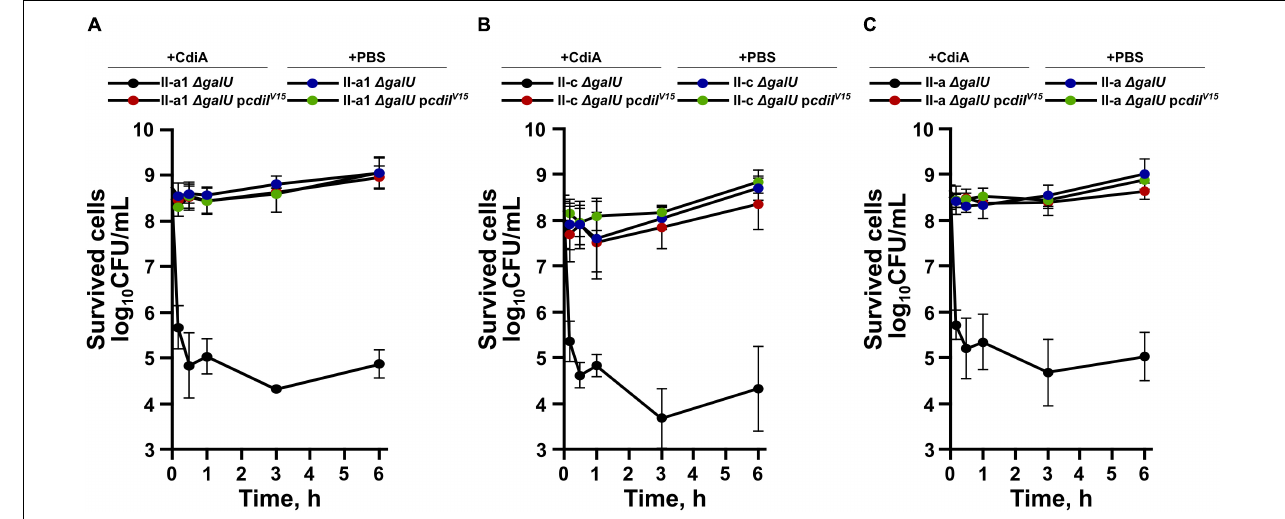
FIGURE 5 | Time-dependent bacterial viability assays of A. baumannii clinical strains II-a1 (A) , II-c (B) , and II-a (C) , their galU mutants, and galU mutants complemented with immunity gene cdiI V15 from the A. baumannii V15. The viabilities after the addition of either PBS or the purified CdiA were assessed by measuring the remaining bacterial CFUs at the following time points: 0 h, 10 min, 30 min, 1 h, 3 h, and 6 h. Values were calculated from three independent experiments. Error bars represent standard